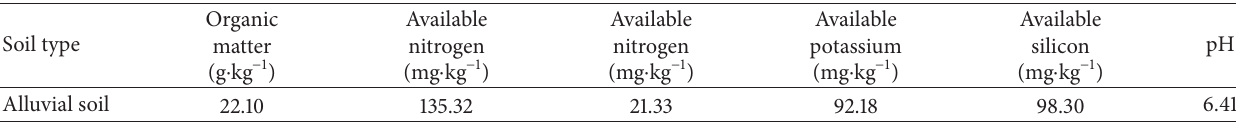
Table 1: Basic properties of studied soils.